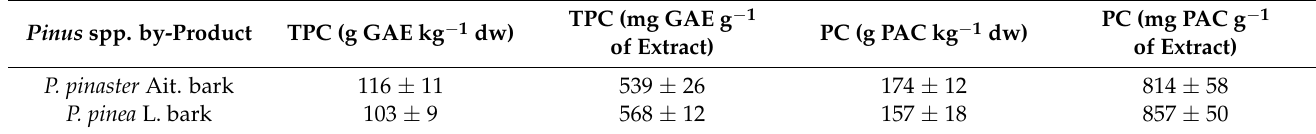
Table 2. Total phenolic content (TPC) and proanthocyanidin content (PC) of Pinus pinaster Ait. and Pinus pinea L. bark polar